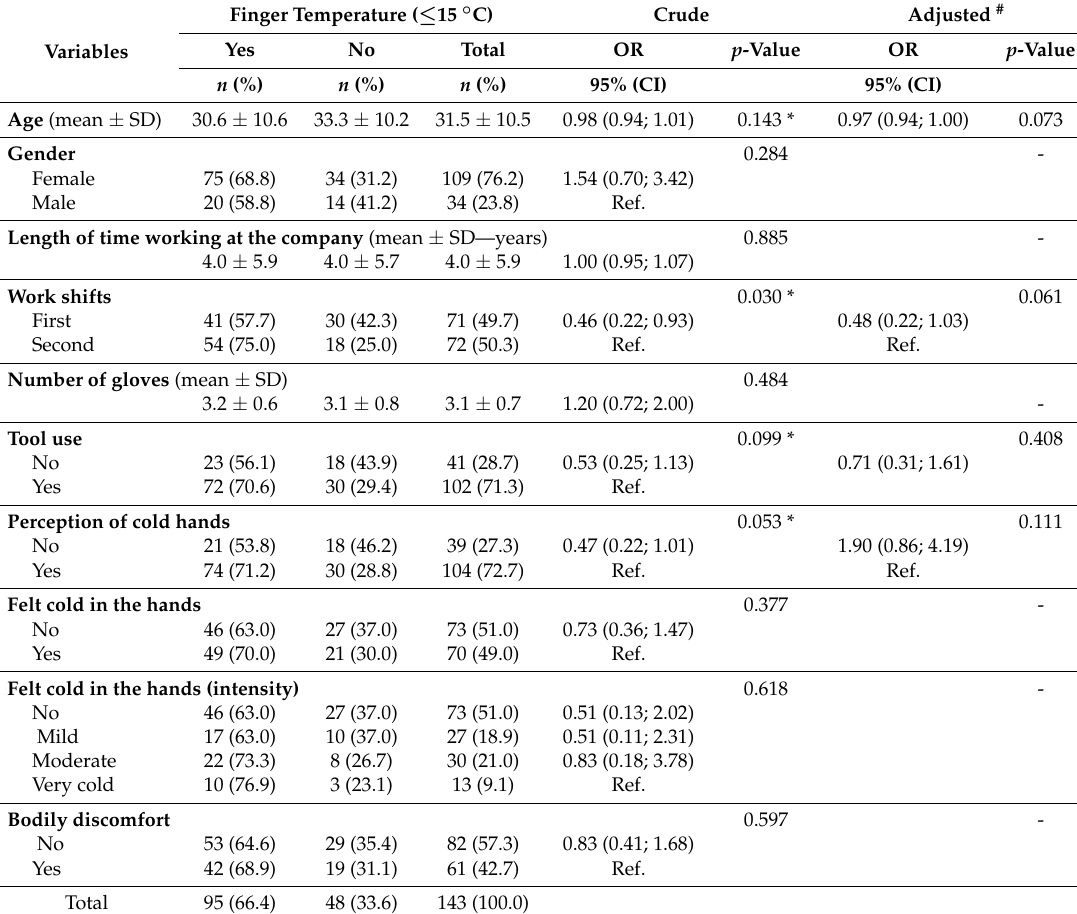
Table 1. Frequency and percent of the variables in relation to hand temperature and crude and adjusted associations between finger temperature and personal and organizational variables, as well as thermal sensation of cold and bodily